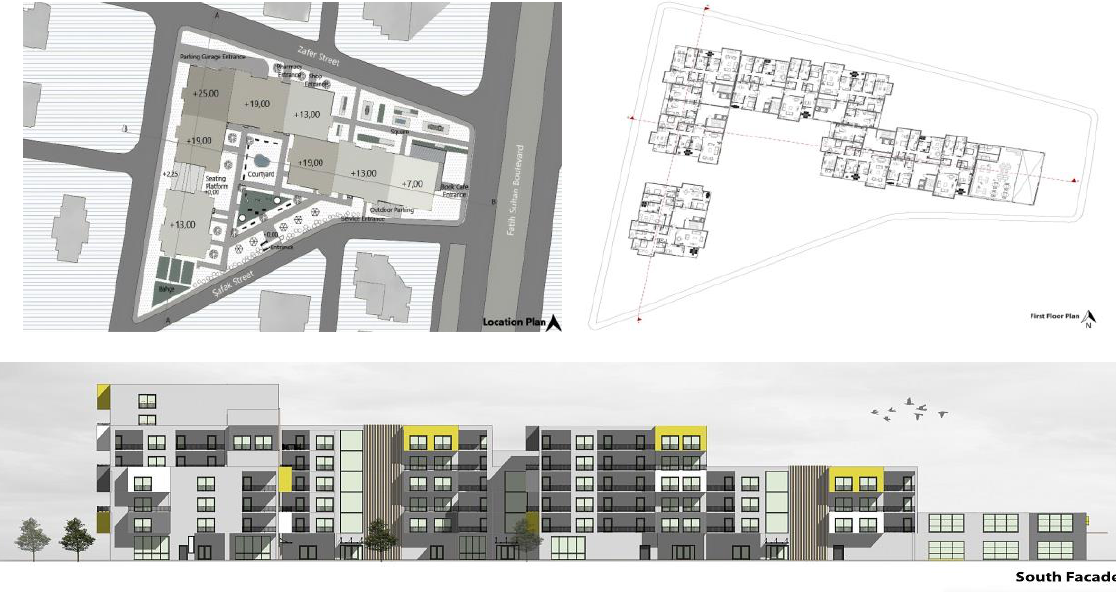
Figure 4. Zeynep Sena Sancak - Modular Living Space